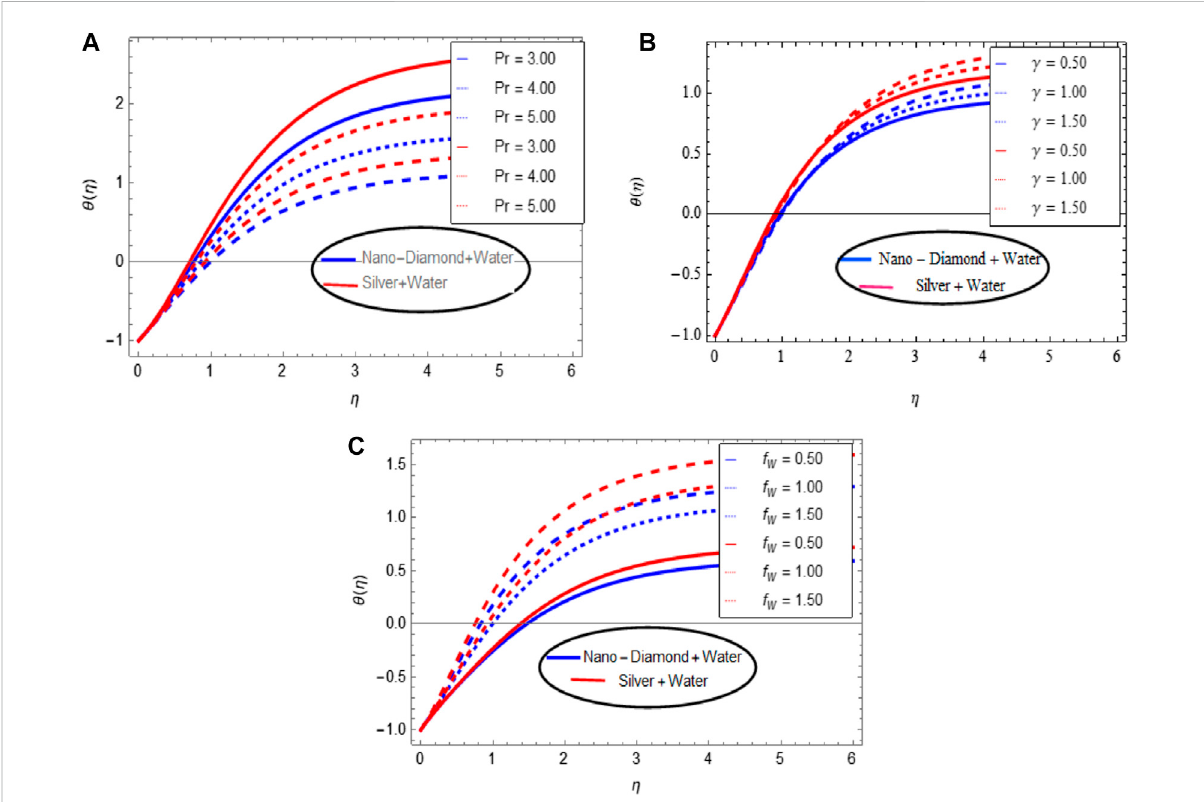
FIGURE 5 In fl uence of (A) Prandtl number, (B) thermal relaxation parameter, and (C) suction/injection on the temperature